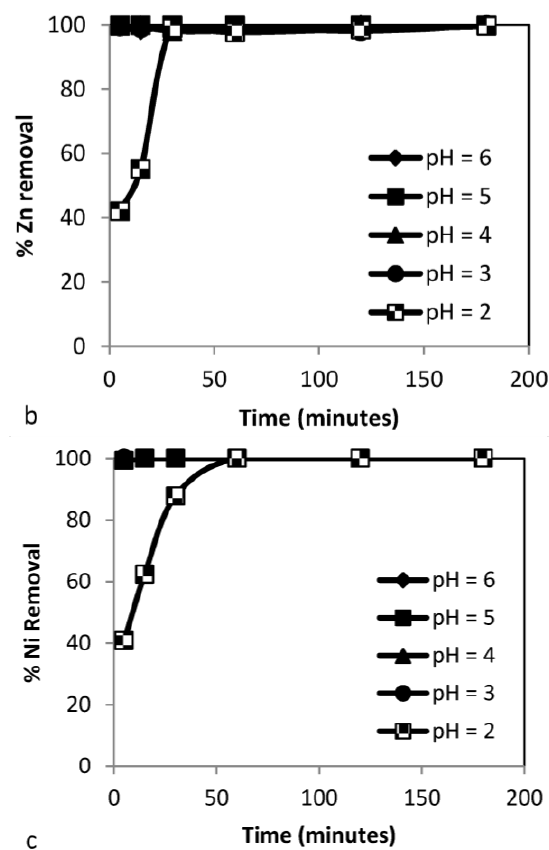
Figure 2. Metals removal by bottom ash as a function of time at different initial pH: ( a ) Cd; ( b ) Zn; and ( c ) Ni.